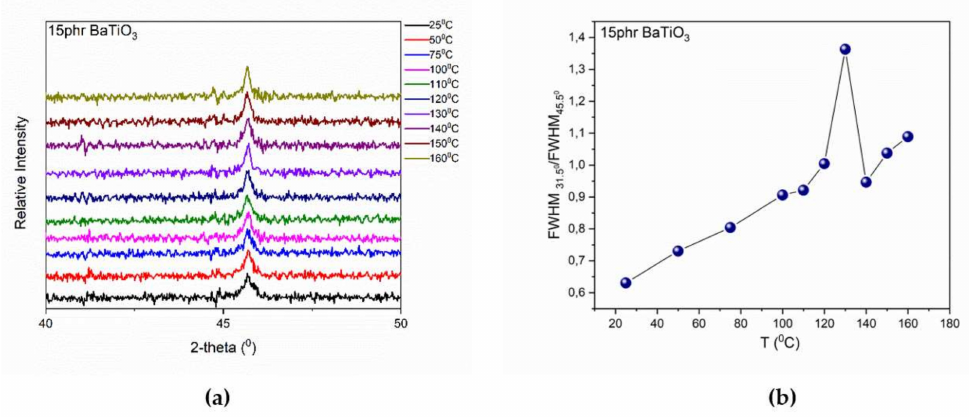
Figure 11. ( a ) XRD patterns in the temperature range from 25 ◦ C to 160 ◦ C and ( b ) FWHM 31.5 ◦ / FWHM 45.5 ◦ as function of temperature for the 15 phr BaTiO 3 / epoxy nanocomposite. Line in Figure 10b is visual